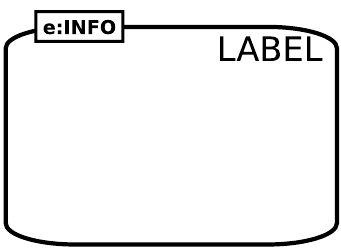
Figure 2.9: The Activity Flow glyph for compartment .